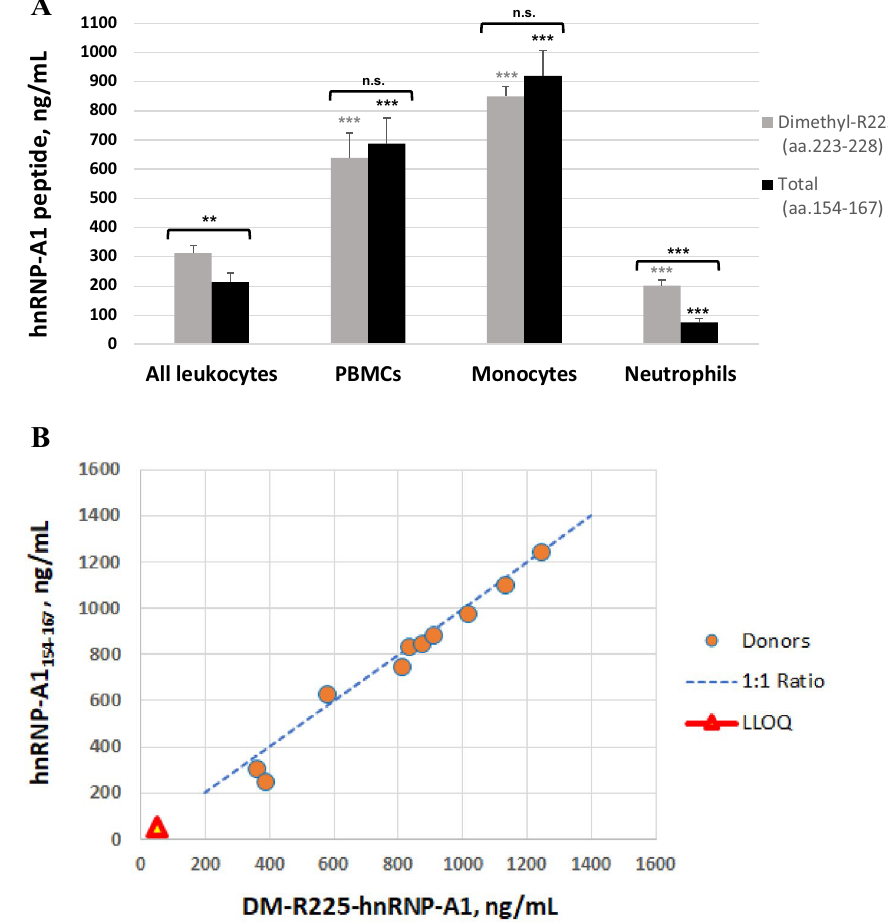
Figure 7. Levels of hnRNP-A1 peptides in human leukocytes. ( A ) Quantitation of DM-R225-hnRNP-A1 and hnRNP-A1 154-167 peptides across human white blood cell populations from four donors (two males and two females; shown is the average ± S.D.). Levels were determined in all leukocytes (inclusive of granulocytes), PBMCs (comprising lymphocytes, monocytes and natural killer cells), monocytes and neutrophils (two- tailed Student’s t test calculated for each peptide in PBMCs, monocytes and neutrophils versus all leukocytes: ** p < 0.01, *** p < 0.001, n.s. not significant; brackets indicate a statistically-significant difference between DM-R225-hnRNP-A1 and hnRNP-A1 154-167 levels). Data are expressed as the mean ± standard deviation (SD). ( B ) Levels of both hnRNP-A1 peptides in human PBMCs obtained from ten donors (five males and five females). LLOQ, lower limit of